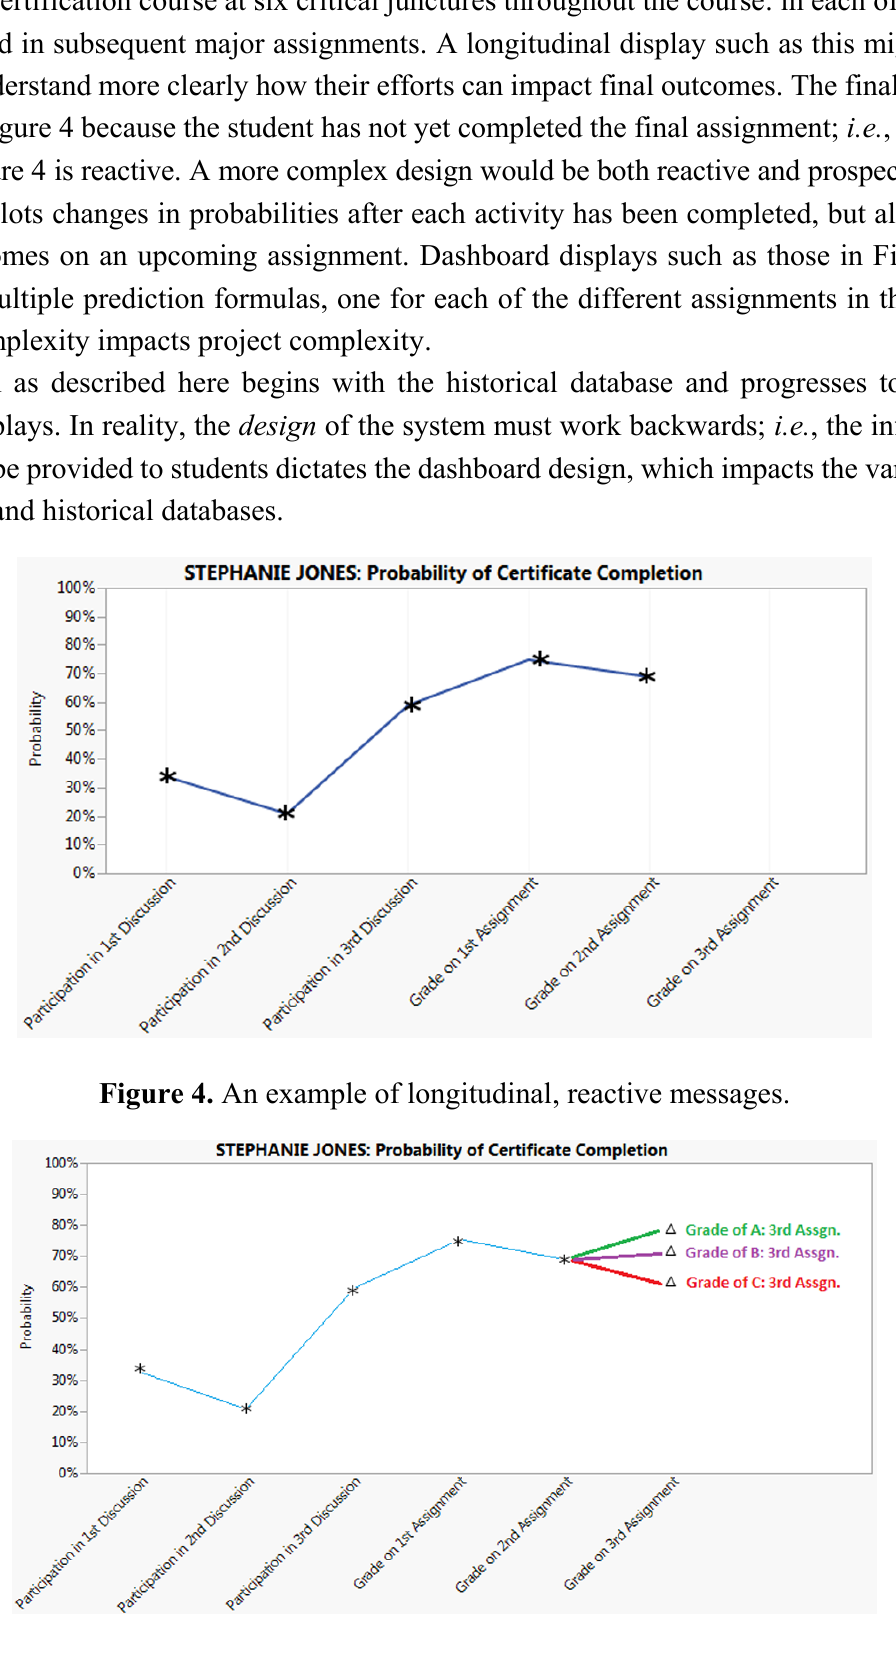
Figure 5. An example of reactive and proactive